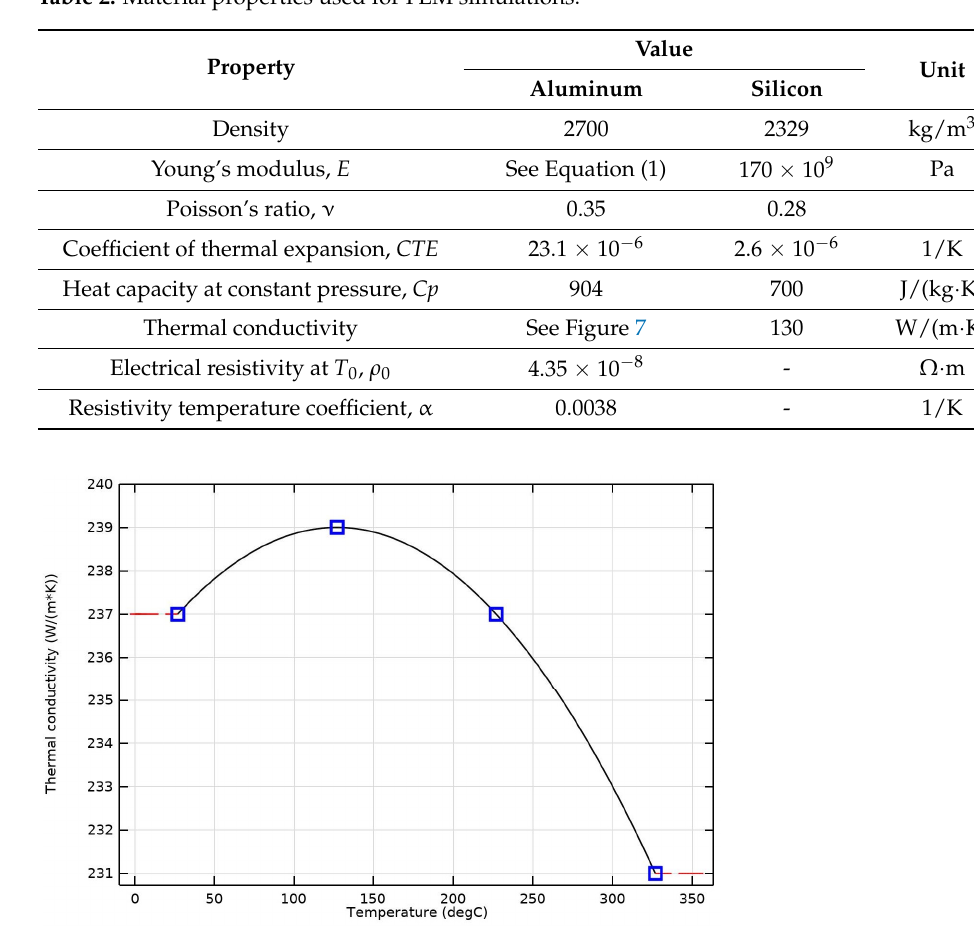
Table 2. Material properties used for FEM simulations.